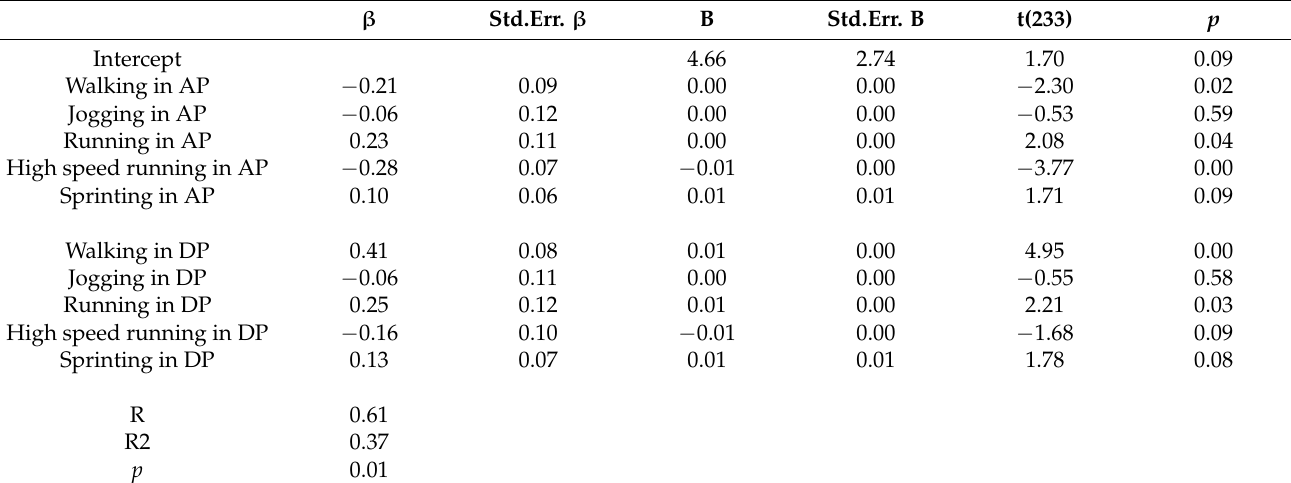
Table 5. Multiple regression calculation for total points earned at the end of the group stage of